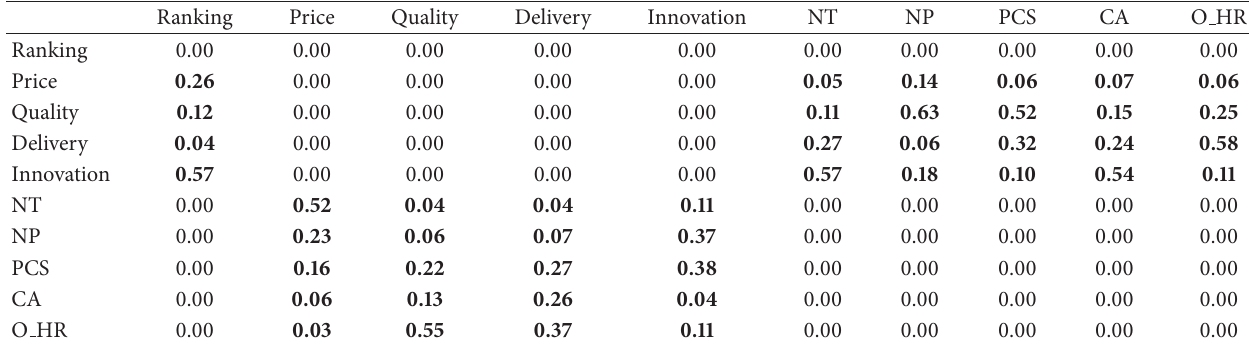
Table 5: Normalized supermatrix of decision agent 2.